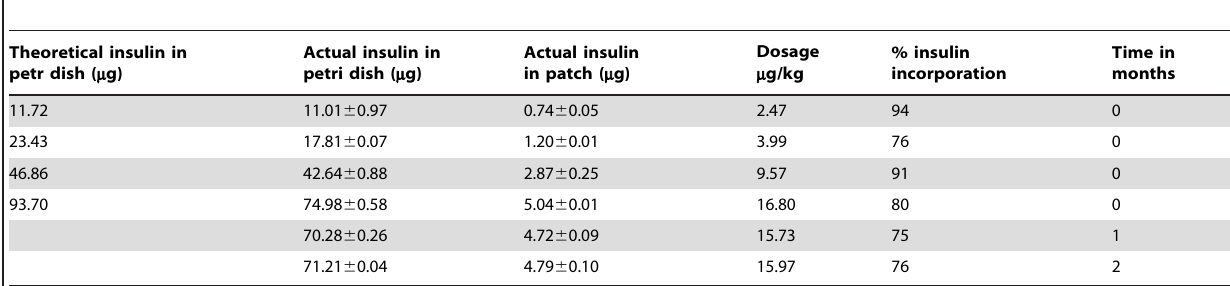
Table 1. Insulin-loading in pectin hydrogel matrices and mean loading-efficiencies: Each value represents the mean value of six different